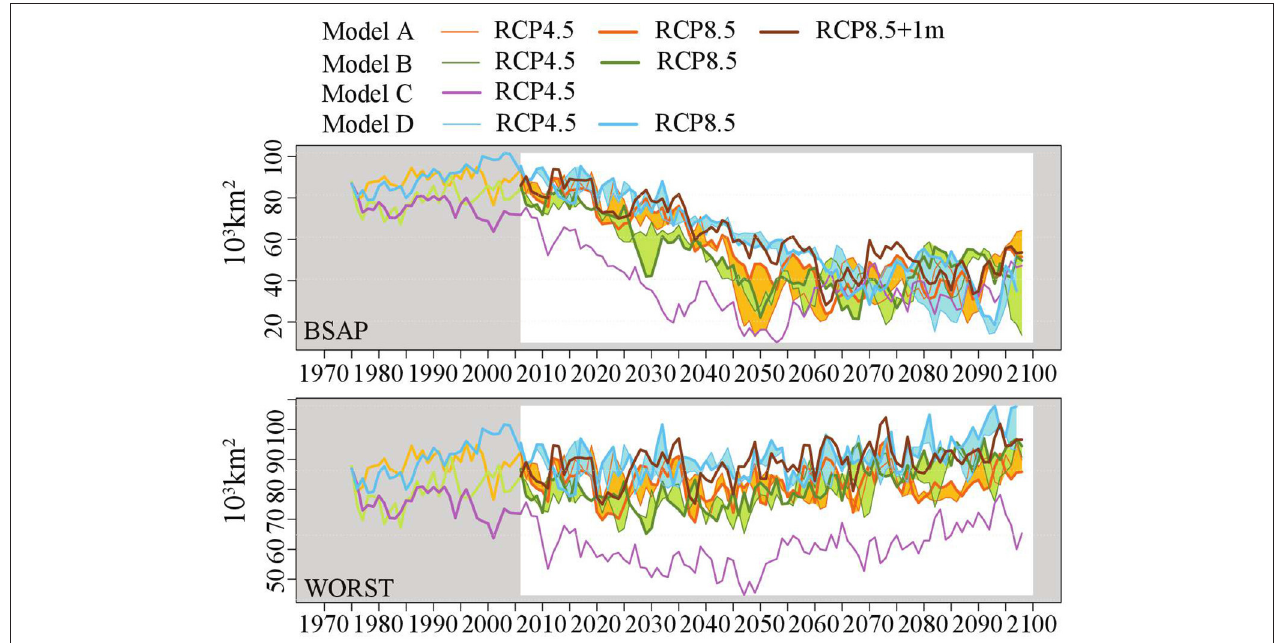
FIGURE 11 | As the upper panel in Figure 10 but for hypoxic area under the BSAP and Worst Case scenarios.